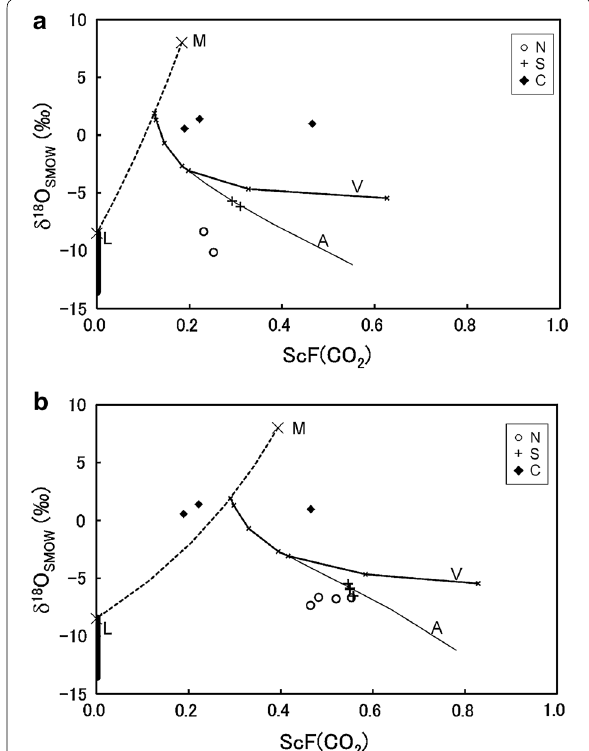
Fig. 10 Correlation between δ 18 O of H 2 O and CO 2 /H 2 O ratio. The bold line on y‑axis indicates the vapor phase generated from local meteoric water (L) at 100 °C. M: magmatic H 2 O with CO 2 (900 °C), L: local meteoric water (15 °C), V: H 2 O vapor with CO 2 (265 °C), A: condensation of H 2 O vapor with CO 2 at 100 °C. In the figures ( a ) and ( b ), the CO 2 /H 2 O ratio of M was set to be 0.0045 and 0.013, respectively